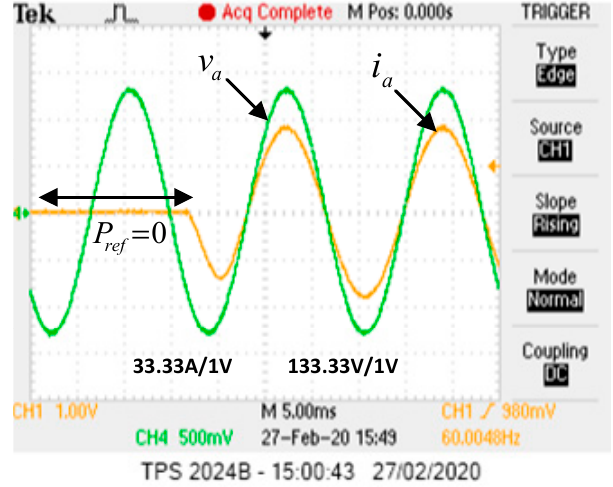
Figure 7. Three-phase output current in steady state for Pref = 10 kW and Qref = 0 kVAr.